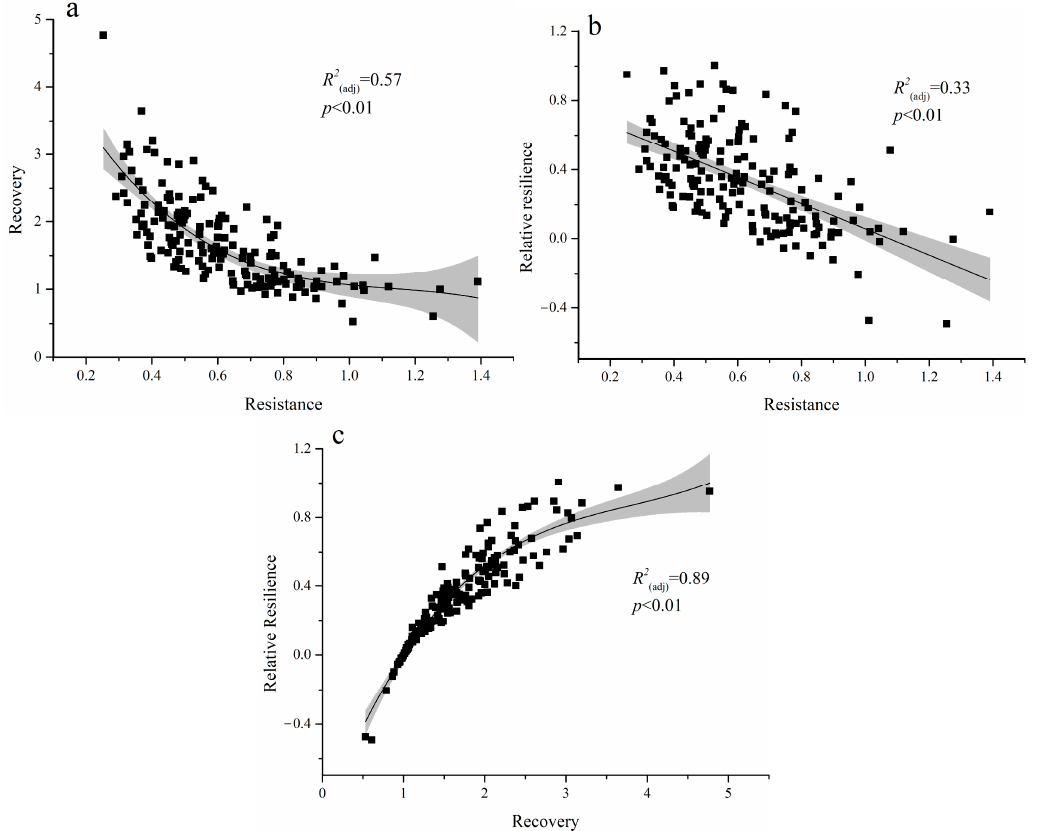
Figure 7. Relationships between resistance indices and recovery indices (a), between resistance indices and relative resilience indices (b), and between recovery indices and relative resilience indices (c) at a regional scale. The black line is the fitted line with 95% confidence interval (grey part).